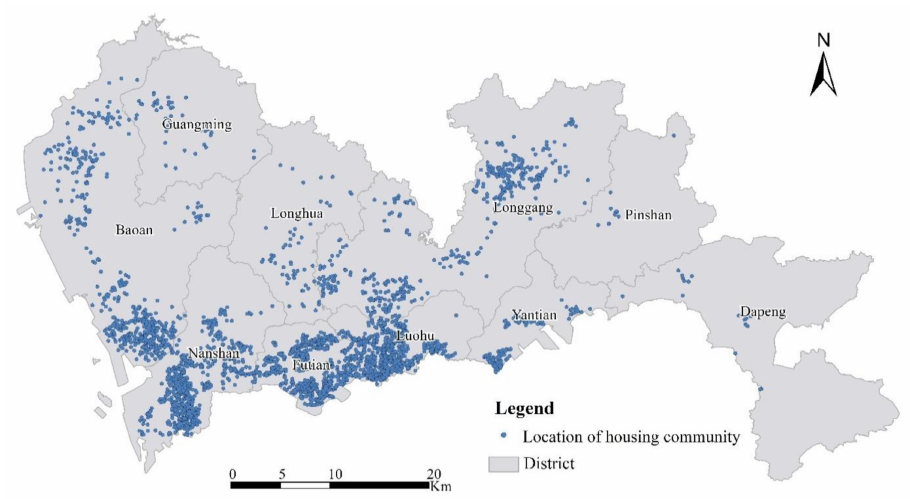
Figure 2. The study area: Shenzhen and the locations of the